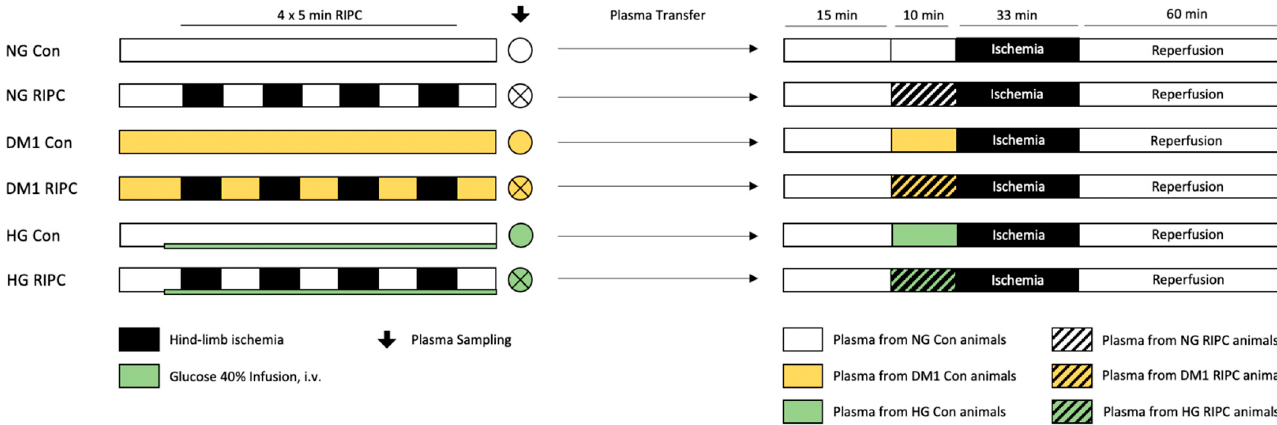
Figure 3. Experimental protocol part 1. Con = control; RIPC = remote ischemic preconditioning; NG = normoglycemia; DM1 = diabetes mellitus type 1; HG = hyperglycemia.